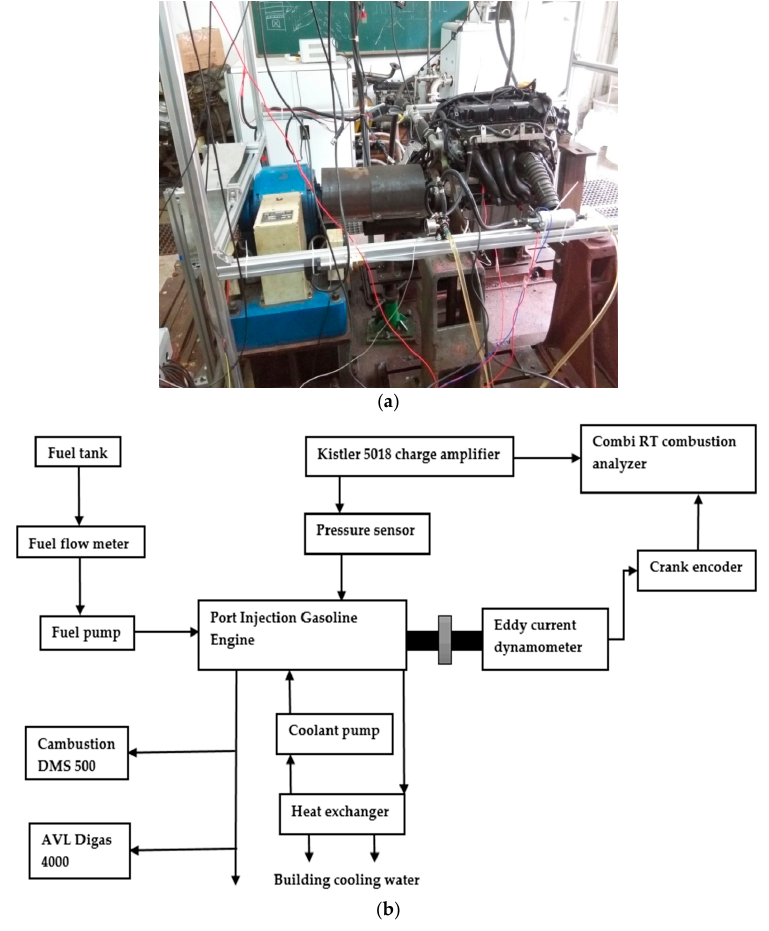
Figure 2. ( a ) The research engine; ( b ) schematic of the experimental setup.